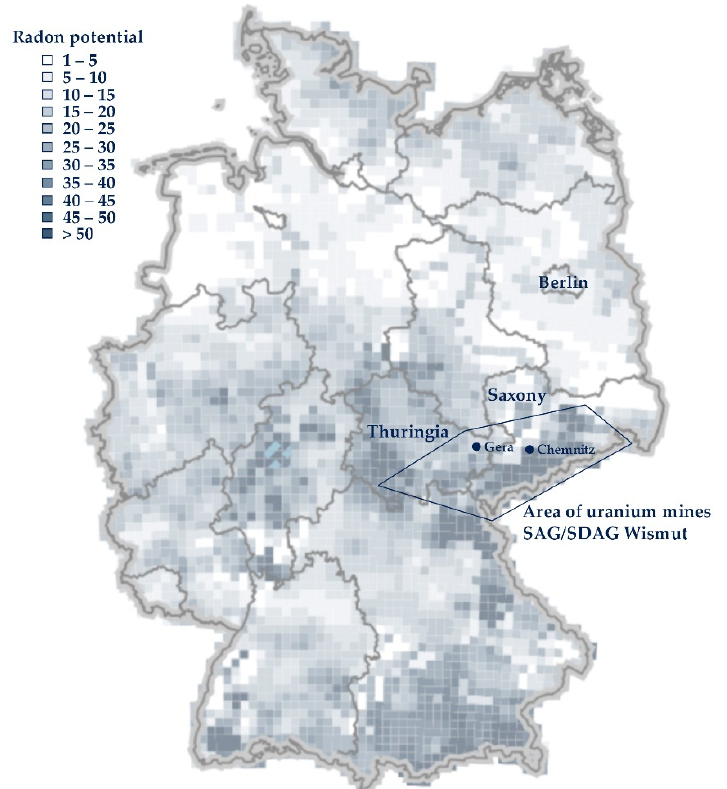
Figure 1. Localization (black pentagon) of the former SAG/SDAG Wismut uranium mines within Germany. Most of the mines are located near Gera (Thuringia) and Chemnitz (Saxony). The underlying radon potential (dimensionless variable) 1 m underground is indicated by the color code in the map [3]. The area of the uranium mines has naturally high radon concentrations in the soil and air. Figure 1 was modified from the map generated by (https://www.imis.bfs.de/geoportal/ accessed 9 November 2021).